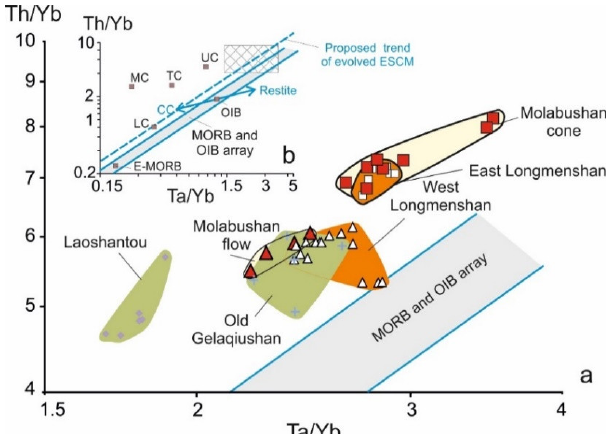
Figure 16. Th/Yb versus Ta/Yb diagrams that demonstrate deviations of Wudalianchi rocks from the MORB and OIB array ( a ) and the continental crust compositions (LC—lower, MC—middle, UC—upper, TC—total) ( b ). Symbols are as in Figure 5. The bi-directional dark-blue arrow on (b) shows the advanced